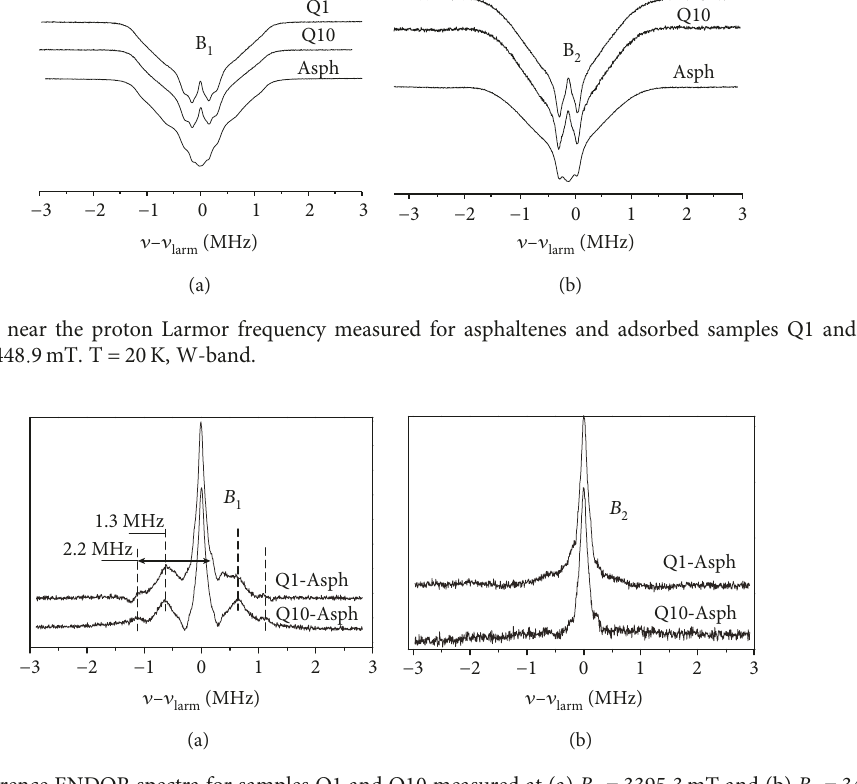
= 3395 3 mT and (b) B = 3448 9mT 1 2